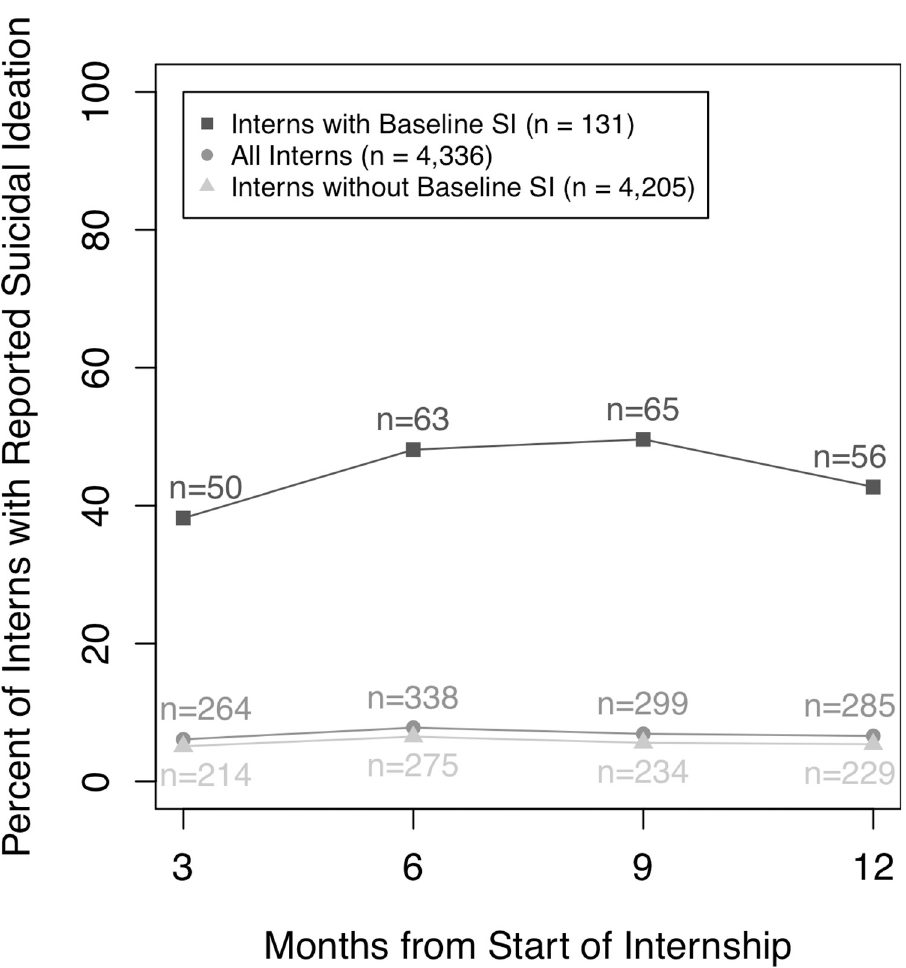
Fig 1. Prevalence of reported suicidal ideation by quarter of internship and baseline intern suicidal ideation status. Prevalence rates calculated among interns in the 2012–2015 cohorts ( n = 4,336). SI = suicidal ideation.